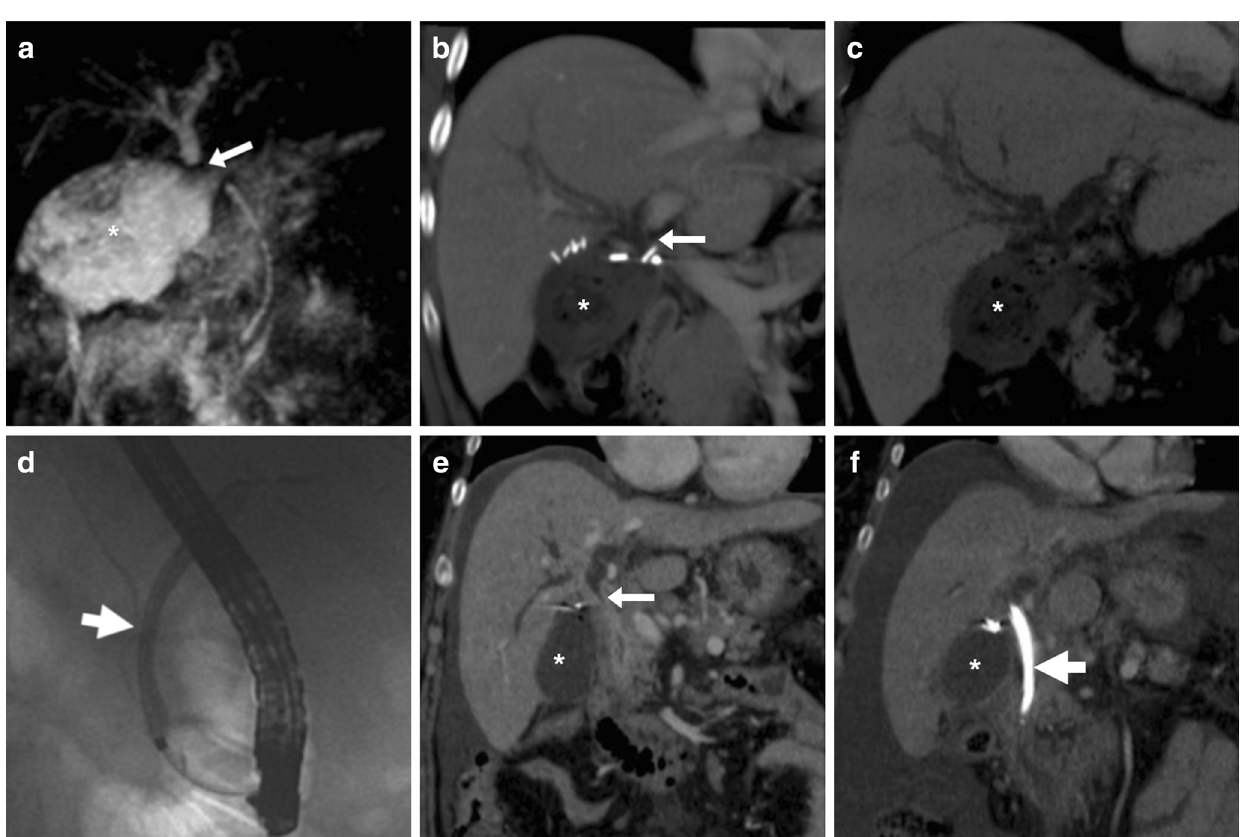
Fig. 18 Two patients with biliary obstruction from iatrogenic early post- laparoscopic cholecystectomy biliary injuries. a – d On the 5th postopera- tive day, MRCP ( a ) showed usual postoperative collection at gallbladder fossa (*), dilated intrahepatic ducts and proximal CBD with abrupt ter- mination ( arrow ) and normal choledochus distally to the discontinuity. Additional focused contrast-enhanced CT image ( b ) better showed the metallic clips and the MIP image ( c ) depicted the dilated intrahepatic bile ducts. The dilated common hepatic duct measured 14 mm in length,